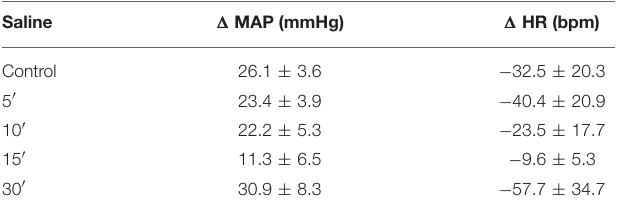
Frontiers in Physiology |